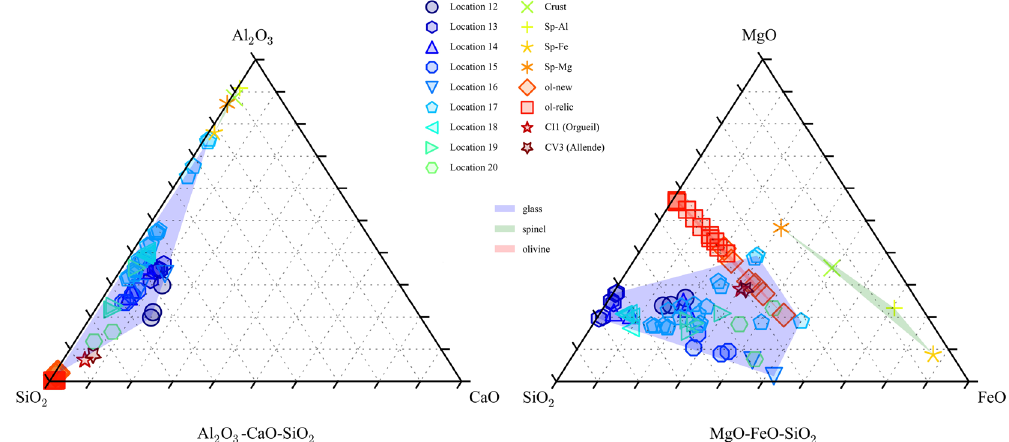
Figure 5. Compositions of glass regions in 126A. They are presented in terms of weight % Al 2 O 3 -CaO-SiO 2 (left) and MgO-FeO-SiO 2 (right) and normalized to 100%. The three shaded regions are the convex hulls of glass (blue), spinel (green), and olivine (red) compositions; each shaded region shows, roughly, the range of compositions for one of the three phases. Locations refer to those shown in Fig. 2b. Compositions vary widely both within the same region (see, e.g., Location 17) as well as across different regions. Also plotted for comparison are bulk compositions of the Orgueil (CI1) chondrite 59 (Fe 2 O 3 from original analyses has been recalculated to FeO) and of the Allende (CV3) chondrite 60 . Orgueil’s composition reflects bulk solar abundances, and Allende’s is prototypical of CV3 chondrites. Compared to the bulk compositions of Orgueil and Allende, the glass in Grain 126A contains higher relative abundances of Al 2 O 3 and lower relative abundances of FeO. This is consistent with modification of the matrix melt (which may originally have had composition similar to that of Orgueil and Allende) by assimilation of oxidized Al following redox reaction with Al-Cu-Fe metal. During the reaction, the FeO from the matrix melt reduced to metallic Fe, which then formed Fe beads.